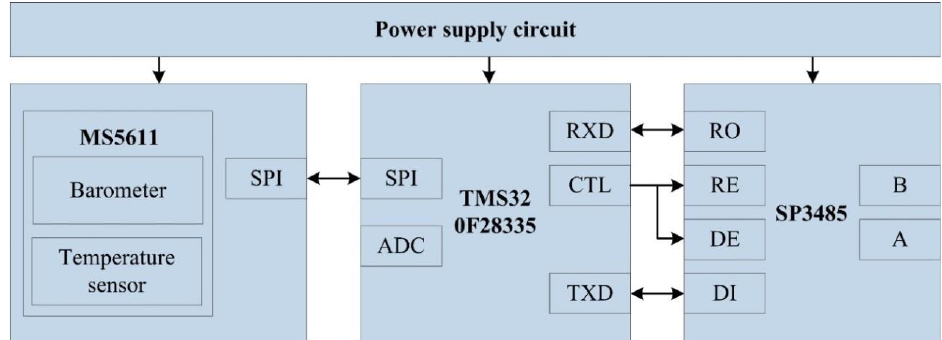
Figure 5. Composition of embedded monitoring terminal.